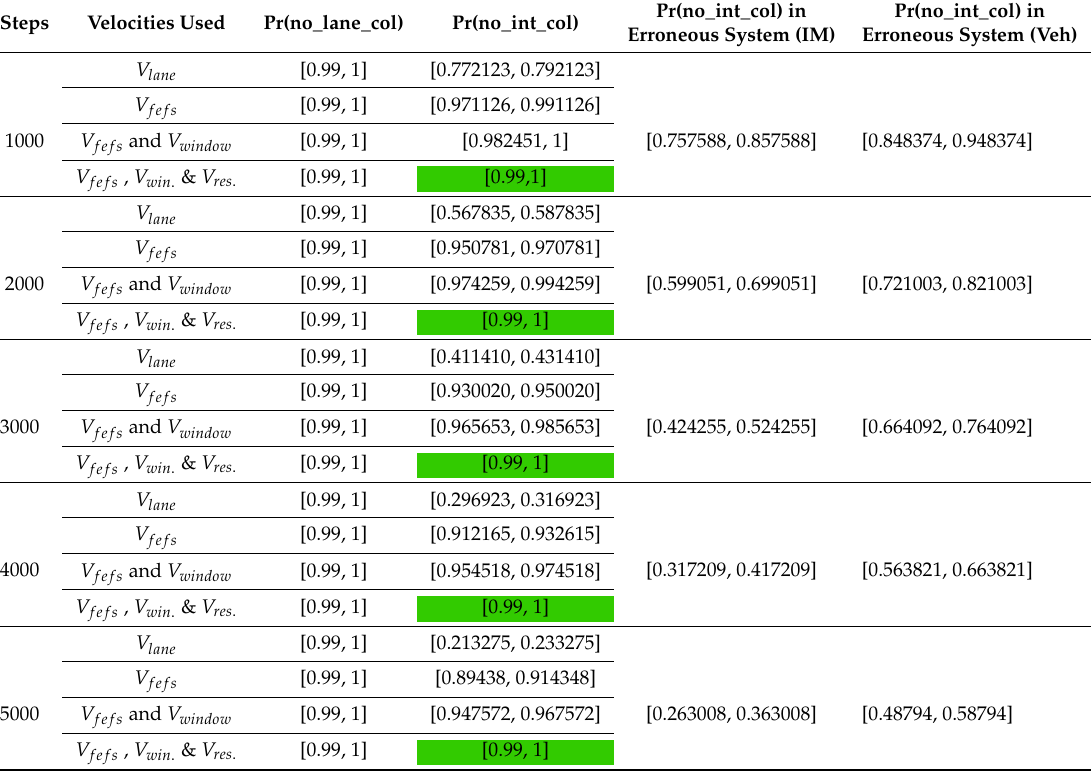
Table 3. Verification